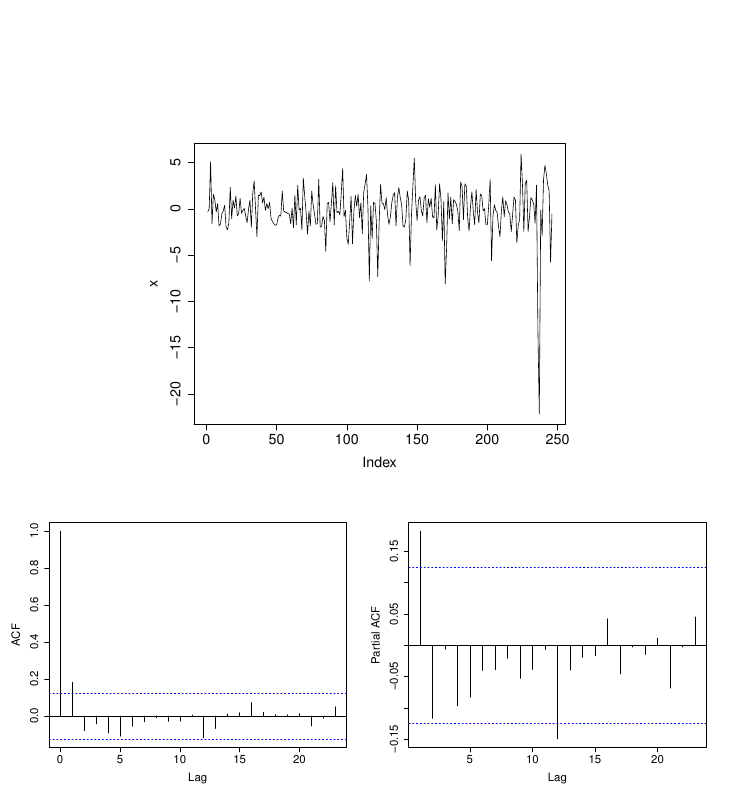
Figure 5 – ACF, PACF plots of the percentage difference of BPCL share price index data.